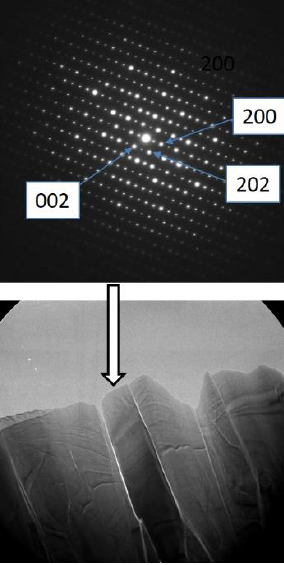
Figure 6. TEM image and electron diffraction pattern of silicalite-1 membranes crystallized for 336 h.